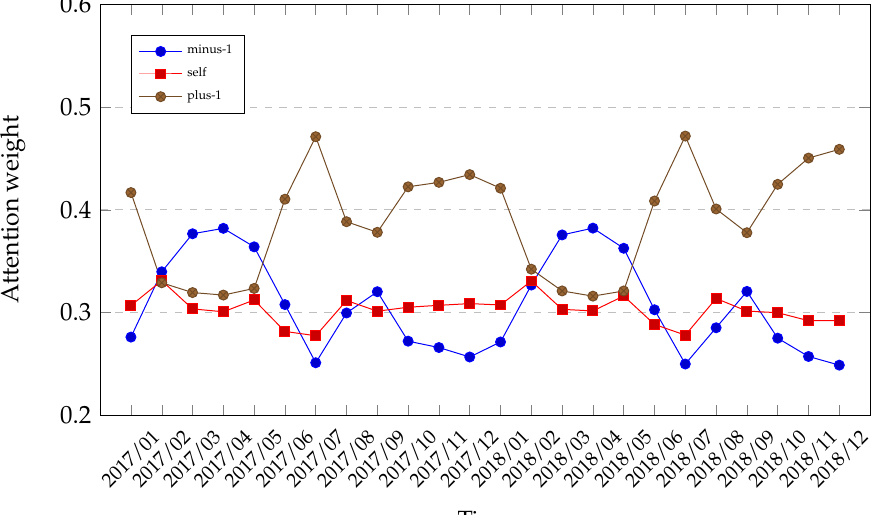
Figure 11. Attention weight of SP-CRN-1 (1,1,0) for SST prediction from the average of five runs. The attention weight of minus-1, self, and plus-1 are the minus one month, prediction month, and plus one month of one prior periodic cycle, respectively. The scale is from 0.2 to